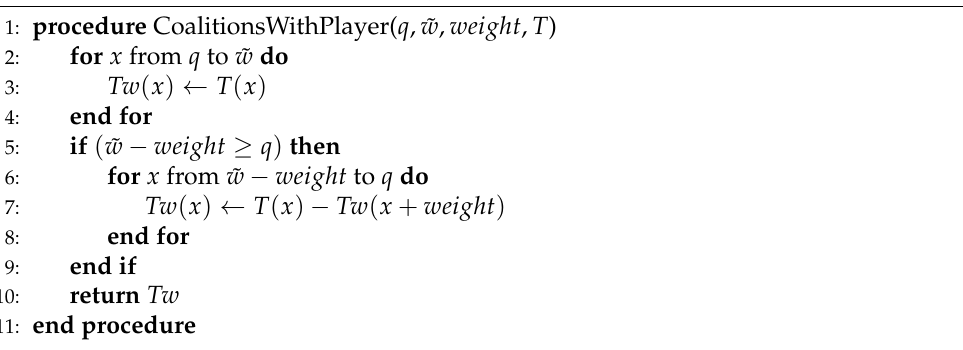
Algorithm 4 Count coalitions containing a player specified by its